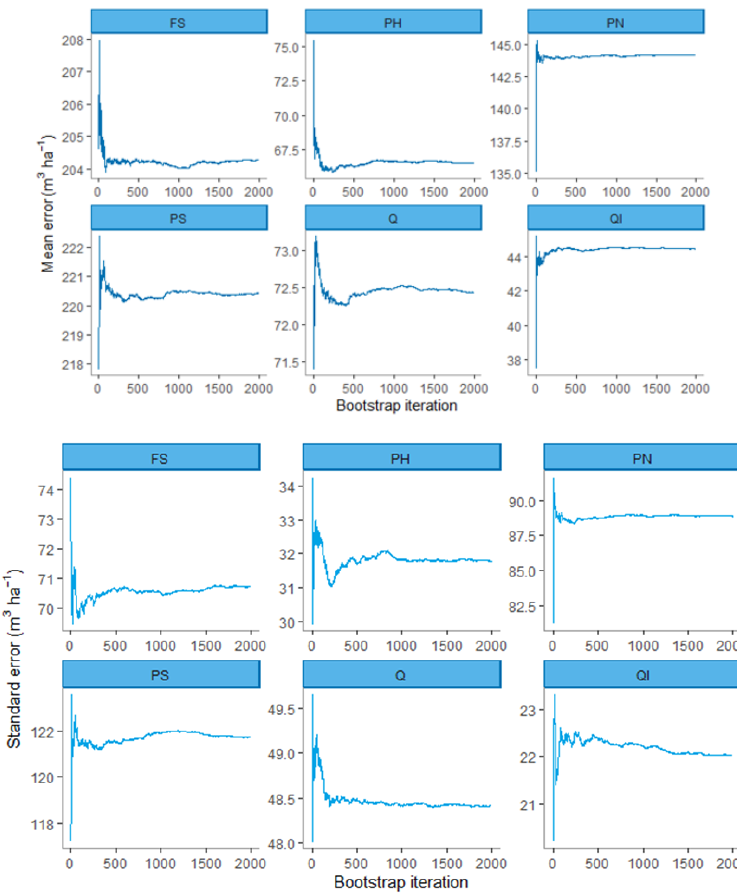
Figure 7. Estimates for means and standard errors for each bootstrap iteration and forest species